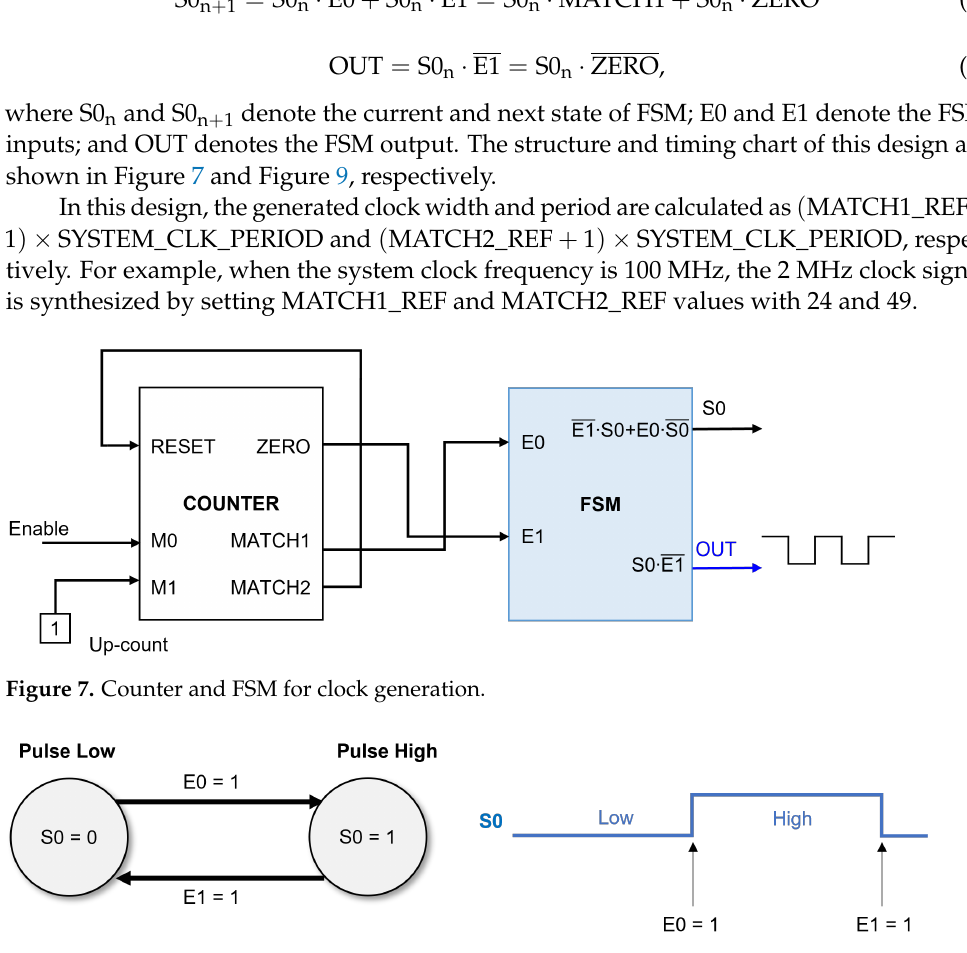
Figure 8. State diagram of clock generation FSM. Table 1. State table of clock generation